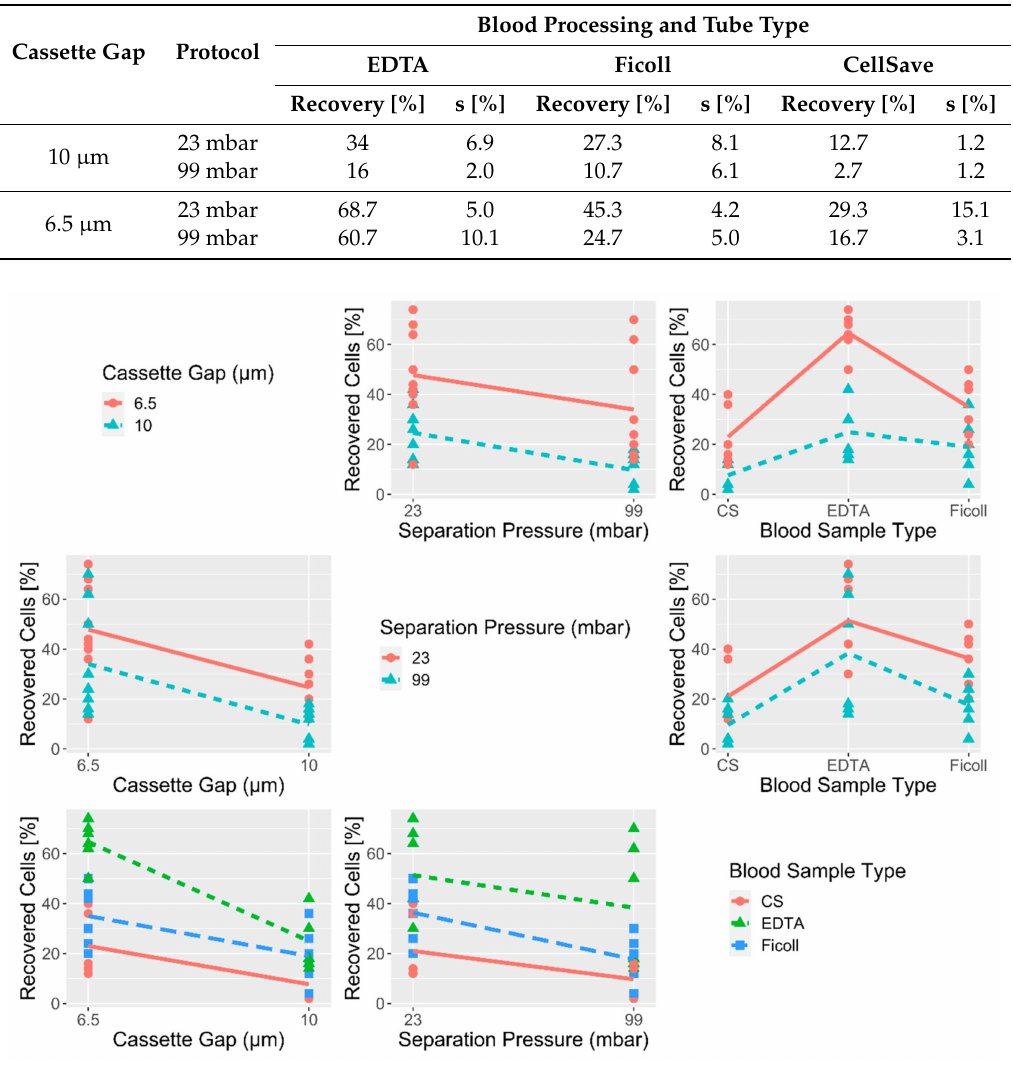
Figure 1. Visualization of initial spike experiment results. Correlation matrix showing the recovery of tumor cells under the di ff erent experimental conditions of the cassette gap (6.5 µ m and 10 µ m), separation pressure (23 mbar and 99 mbar), and the blood sample type (CellSave ® -CS, EDTA and